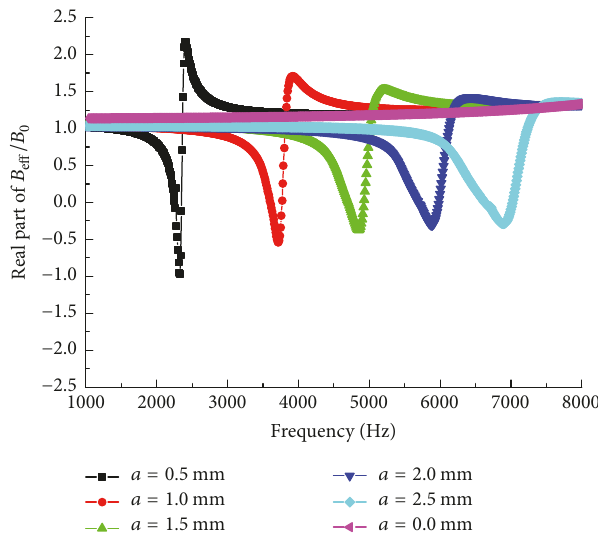
Figure 6: The effective modulus curves of unit cell with different neck radius ( 𝑅 𝑜 = 5.0 mm, 𝑅 𝑖 = 4.5